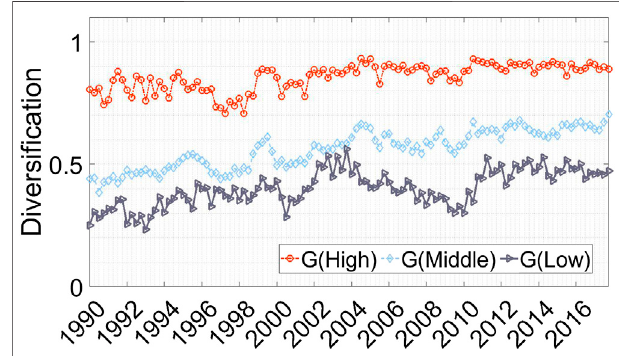
FIGURE 6 | Time series of diversi fi cation of three groups according to their degree centrality. This fi gure shows the time series of the monthly diversi fi cation of syndicated loan portfolios from January 1990 to December 2017. The diversi fi cation of the three groups is computed by using the entropy method based on their loan portfolios. We divided sample into three groups. The red circles, blue diamonds, and black triangles indicate the high, middle, and low-centrality groups, respectively.